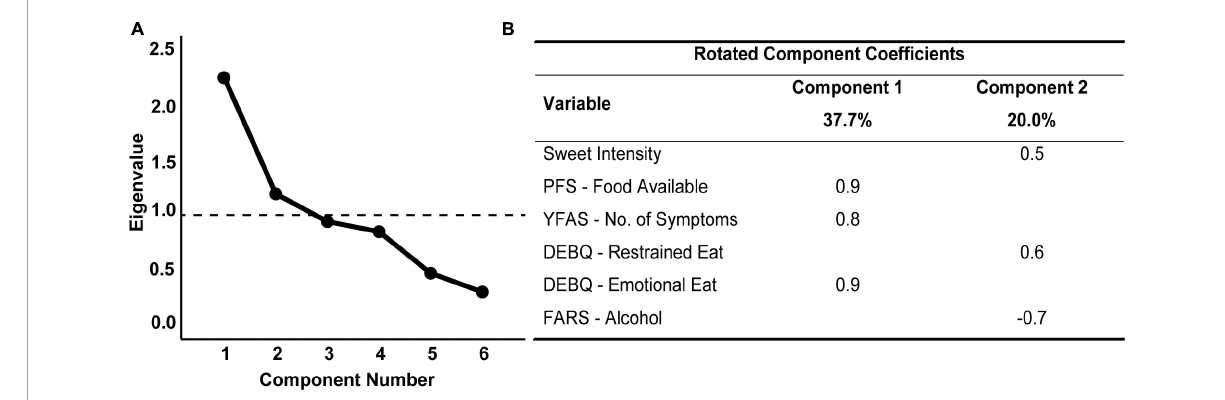
FIGURE3 Scree plot (A) and rotated structure matrix (B) for principal component analysis of gustatory and psychometric variables associated with the obesity group, conducted in the joint sample. Method: Varimax with Kaizer normalization. Major loadings for each loading were kept. Loadings lower than 0.30 were suppressed. The principal component analysis was run with six variables that were previously associated with the obesity group, namely, sweet intensity, hedonic hunger (Power of Food Scale - Food Available), food addiction (Yale Food Addiction Scale - No. of Symptoms), restrained and emotional eating (Dutch Eating Behavior Questionnaire) and acceptance for alcohol (Food Action Rating Scale). N =